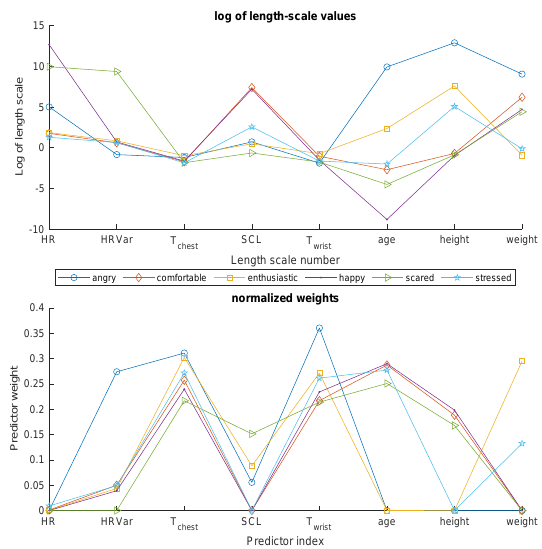
Figure 5. OAD length scale parameters (log values) and parameter weights with SCL parameter.